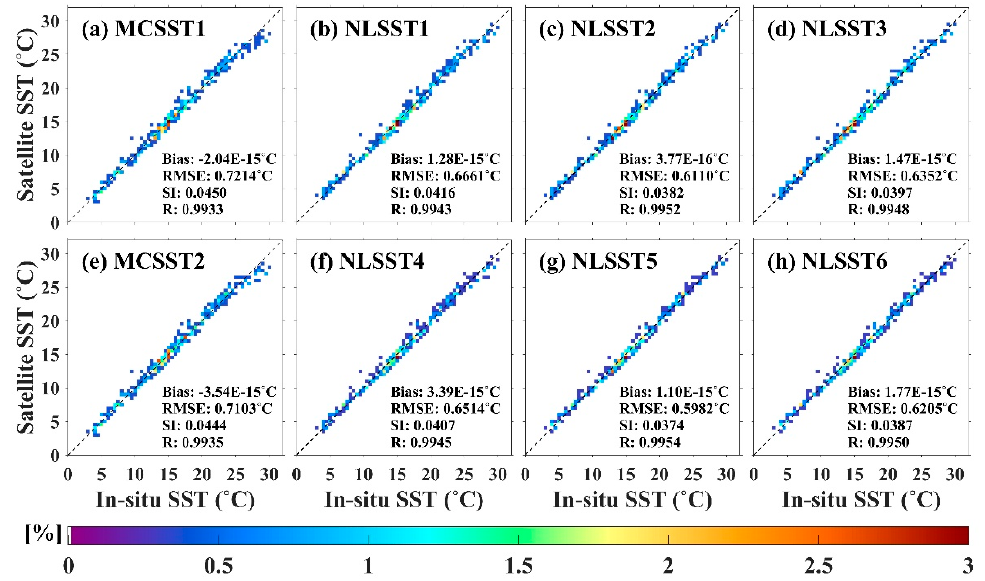
Figure 7. Comparison between satellite derived SST and in-situ temperature using ( a , e ) MCSST and ( b , c , d , f , g , h ) NLSST algorithms, where the color represents the percentage of the data to the total number of matchup points in a bin of 0.5 ◦ C × 0.5 ◦ C. Bias, root-mean-square error (RMSE), scatter index (SI), and correlation coe ffi cient (R) are given in each